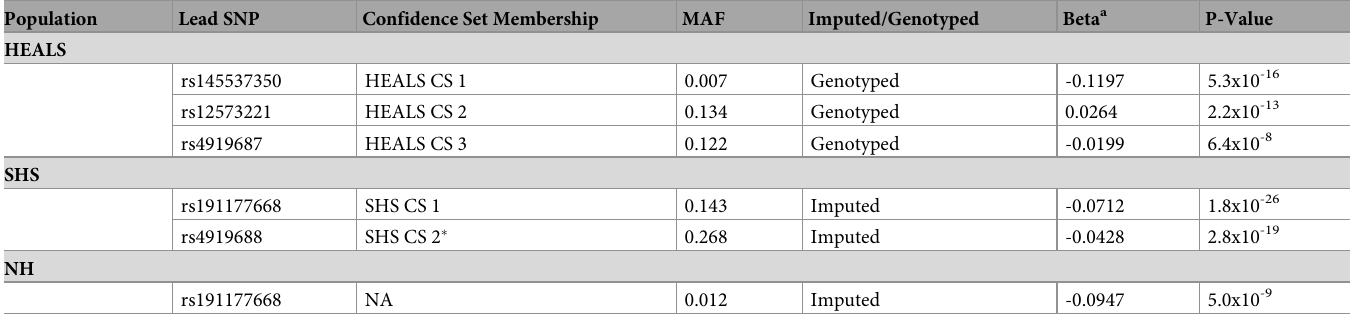
Table 2. Lead SNPs for isolated DMA% association signals by